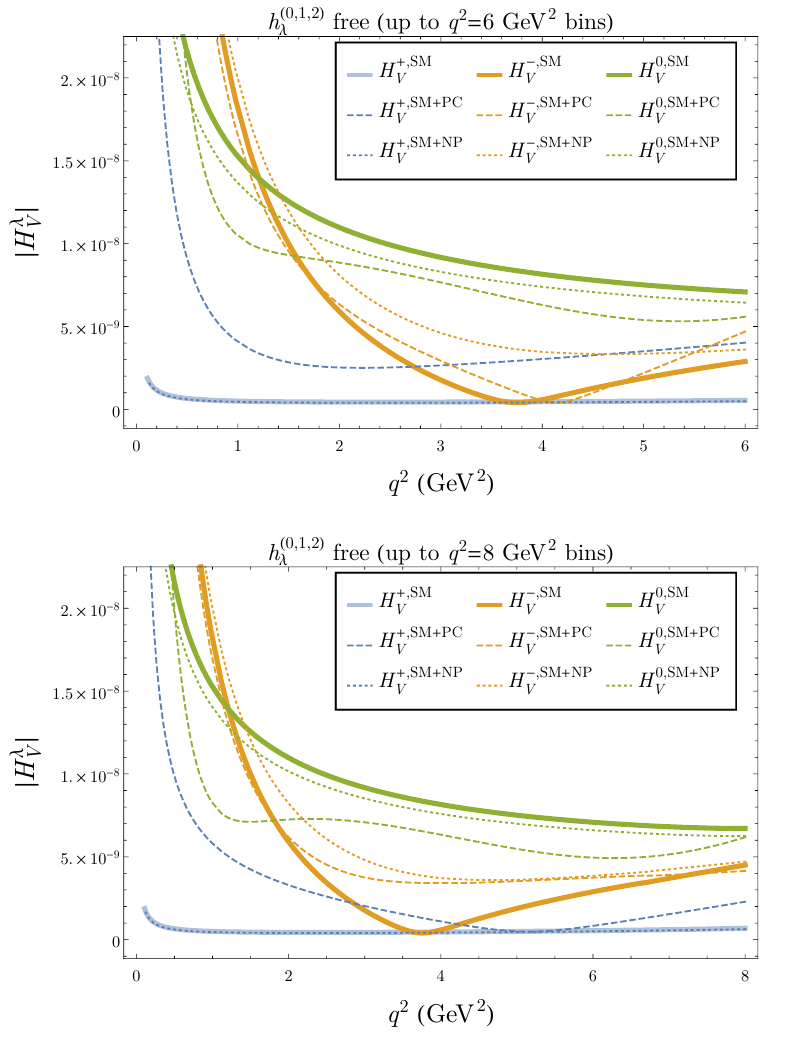
Figure 4 . Behaviour of absolute value of H + and \SM+NP" are shown with solid, dashed and dotted lines, respectively. No constraint is assumed for h (0 ; 1 ; 2)